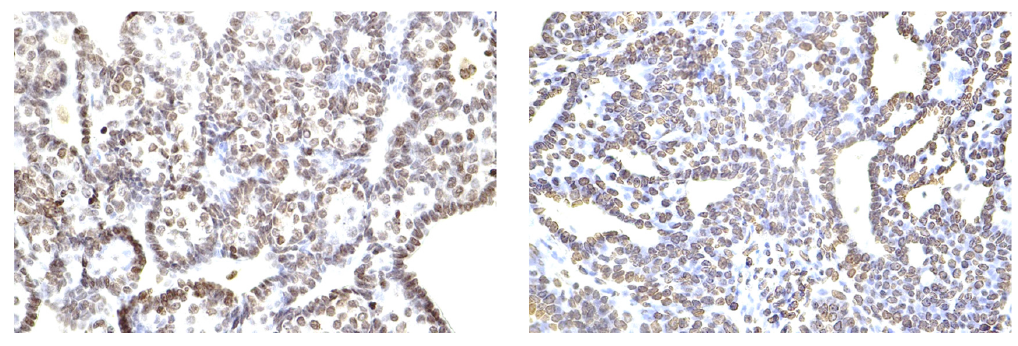
Figure 6. Representative images of expression of cleaved caspase-3, Bax, Bcl-2, Ki67, VEGFA, VEGFR-2, MDA, CD24, CD44, ALDH1A1, EpCam, H3K4m3, H3K9m3, H4K20m3, H4K16ac in rat carcinoma tissue of mammary gland. For